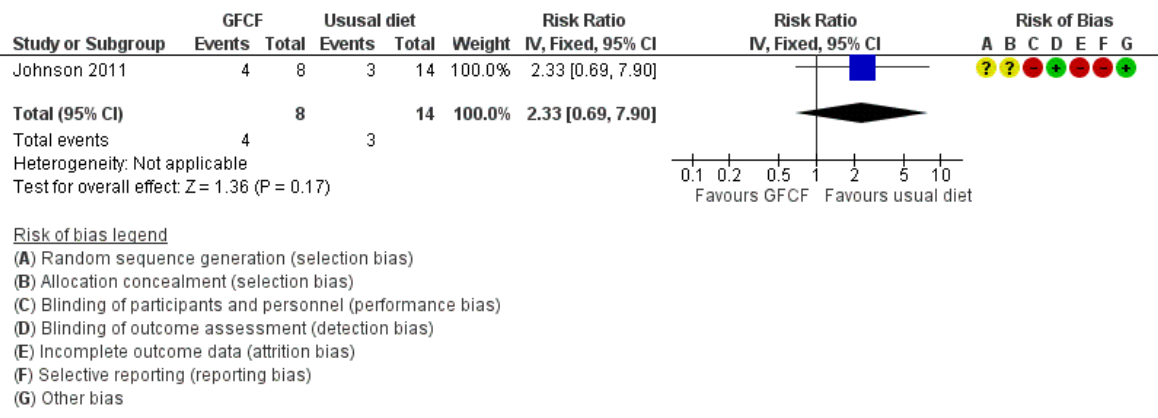
Figure 6. Forest plot of comparison: GFCF vs. usual diet, outcome: number of children with gastrointestinal discomfort.